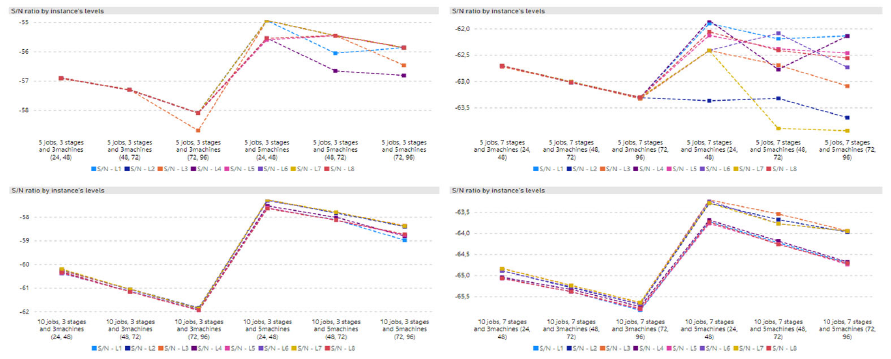
Fig. 7. Taguchi’s Designs by instance level